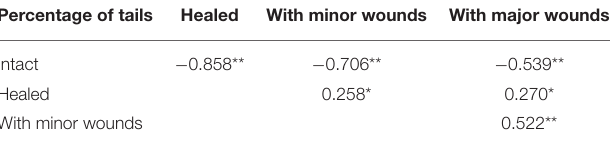
Frontiers in Veterinary Science |